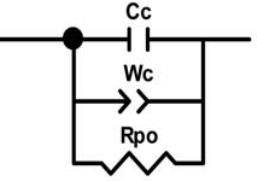
Figure 2. Assumed equivalent electrical circuit for HS alkyd coat- ings with different drier combinations.